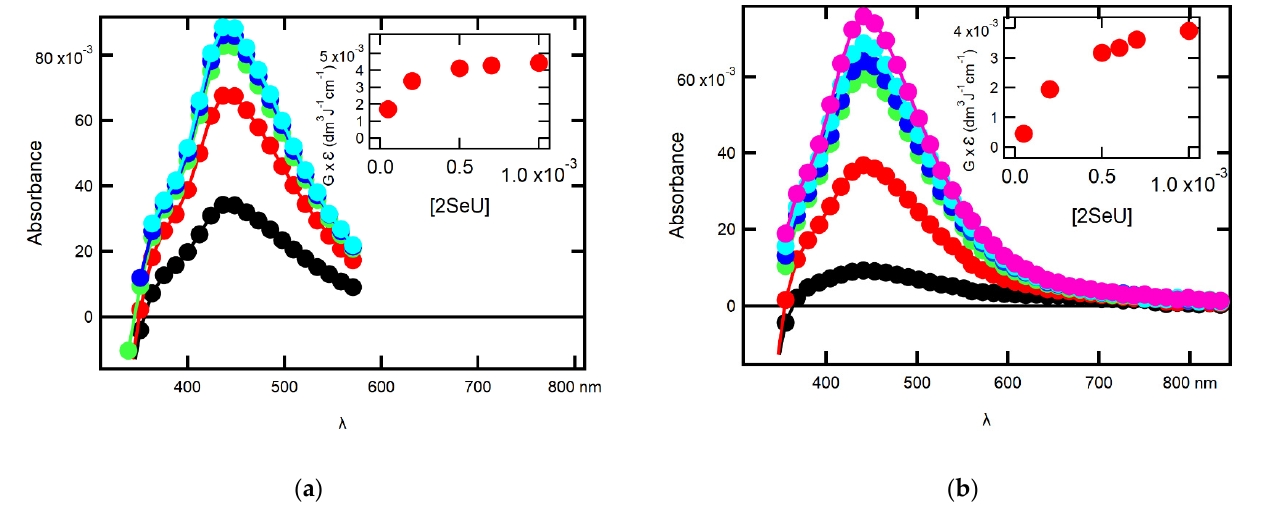
Figure 6. Transient absorption spectra recorded in N 2 O-saturated unbuffered aqueous solutions containing 30 mM NaN 3 : ( a ) at pH 6 containing 0.05 mM ( • ), 0.2 mM ( • ), 0.5 mM ( • ), 0.7 mM ( • ), and 1.0 mM ( ) of 2-SeU recorded 10 μ s, 6 μ s, 3 μ s, 2 μ s, and 1.5 μ s, respectively, after electron pulse; ( b ) at pH 10 containing 0.1 mM ( ), 0.2 mM ( ), 0.5 mM ( ), 0.6 mM ( ), 0.7 mM ( ), and 1 Insets: Maximum absorbances (expressed as G × ε ) recorded at λ = 440 nm in a function of 2-SeU concentration.